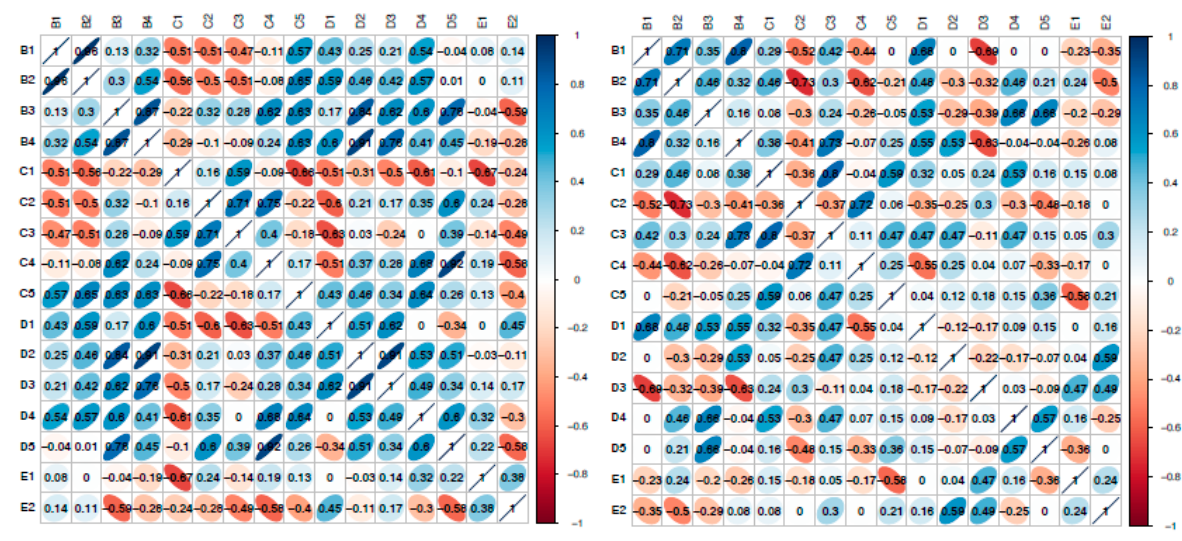
Figure 3. Spearman rank correlation matrices for medical students and dental students surveyed for internal questionnaire validation ( a ) medical, and ( c ) dental and again after a two-week interval ( b ) medical, and ( d ) dental. The color bar indicates the correlation coefficient: dark blue, positive correlation; orange, negative correlation.